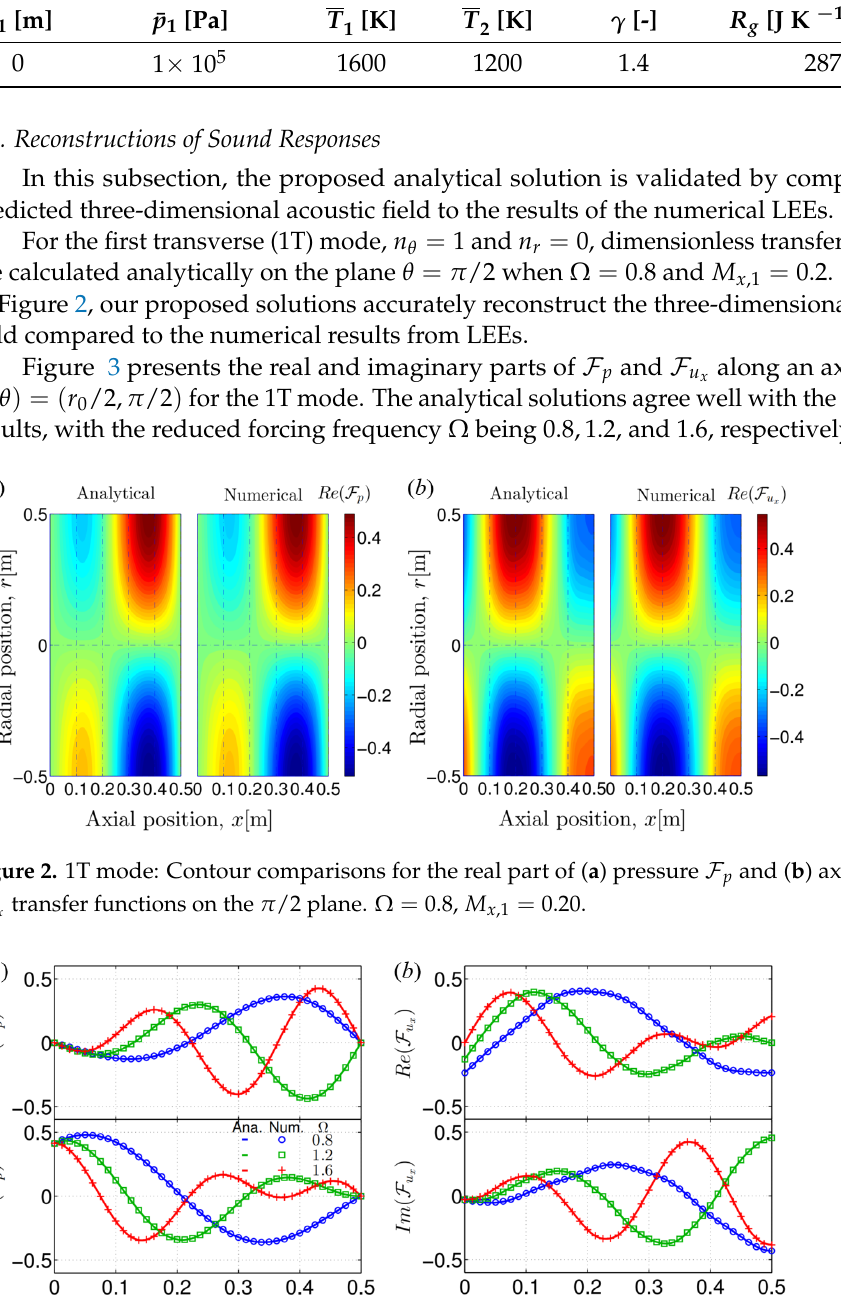
transfer functions along x